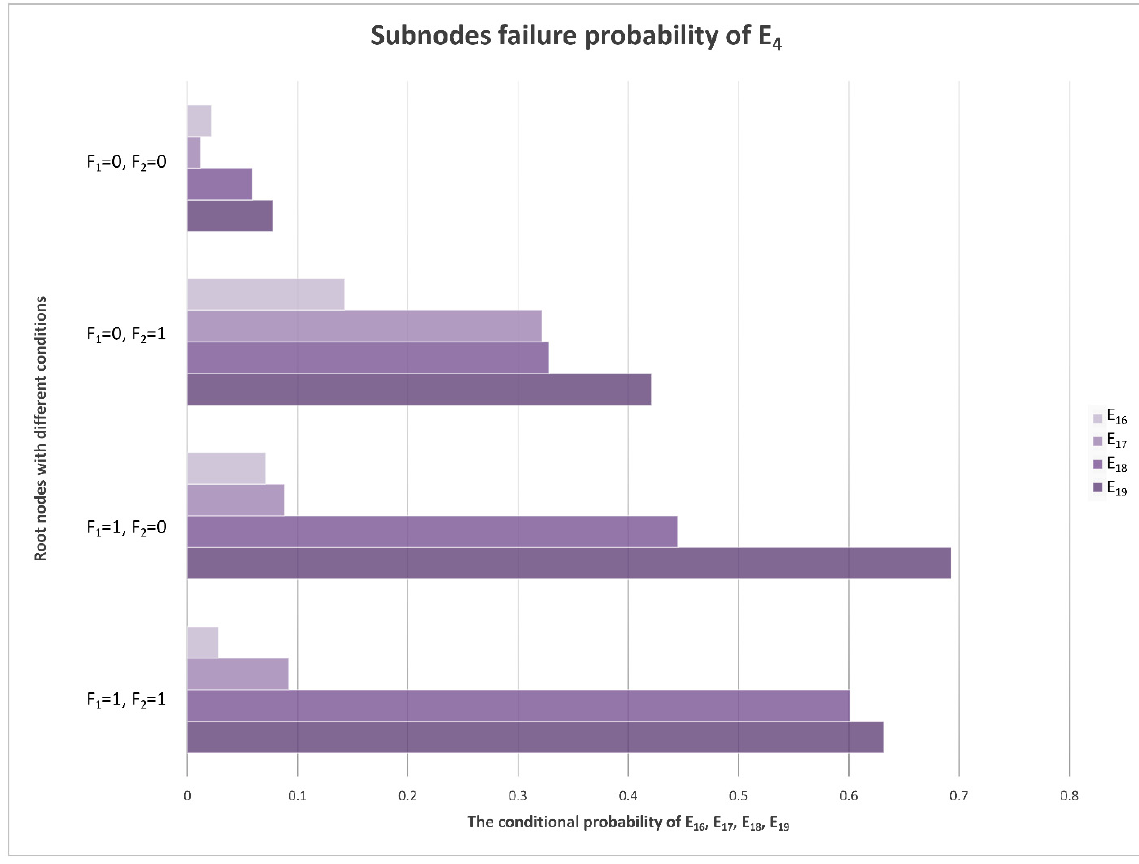
Figure 9. Conditional probability distribution diagram of E 4 ’s sub-nodes.